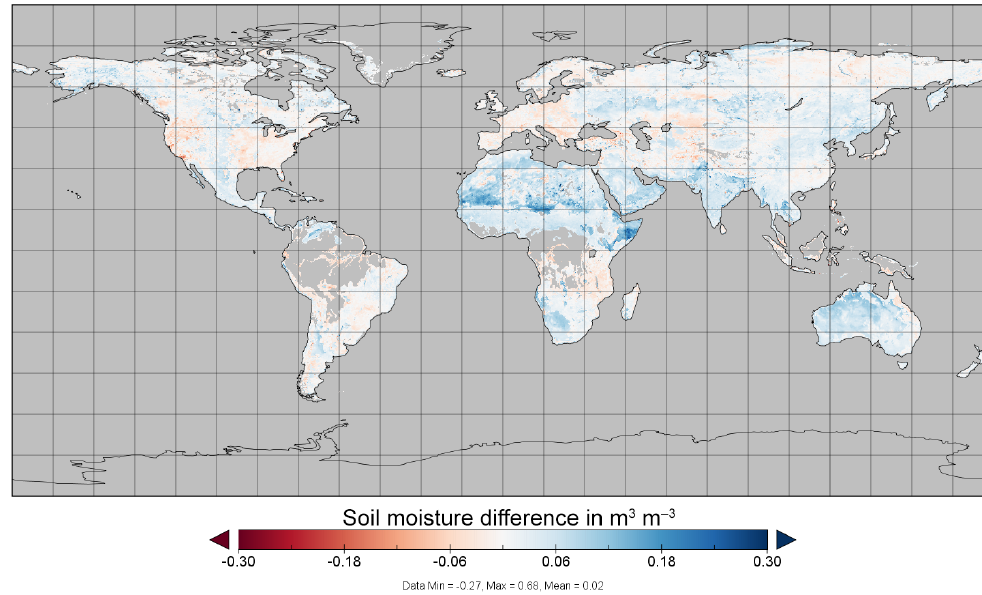
Figure B1. Absolute differences in soil moisture (ESA CCI SM minus CCI NRT) for the entire year 2013.